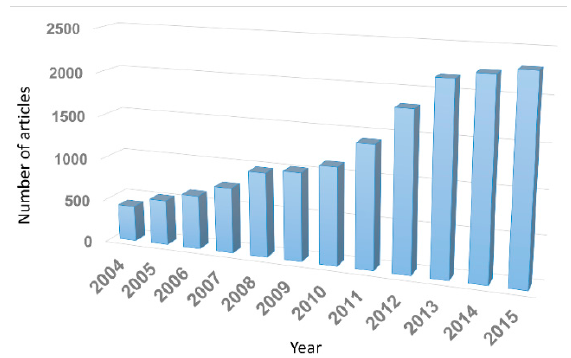
Figure 1. Chemical structures of representative conducting polymers (CPs).